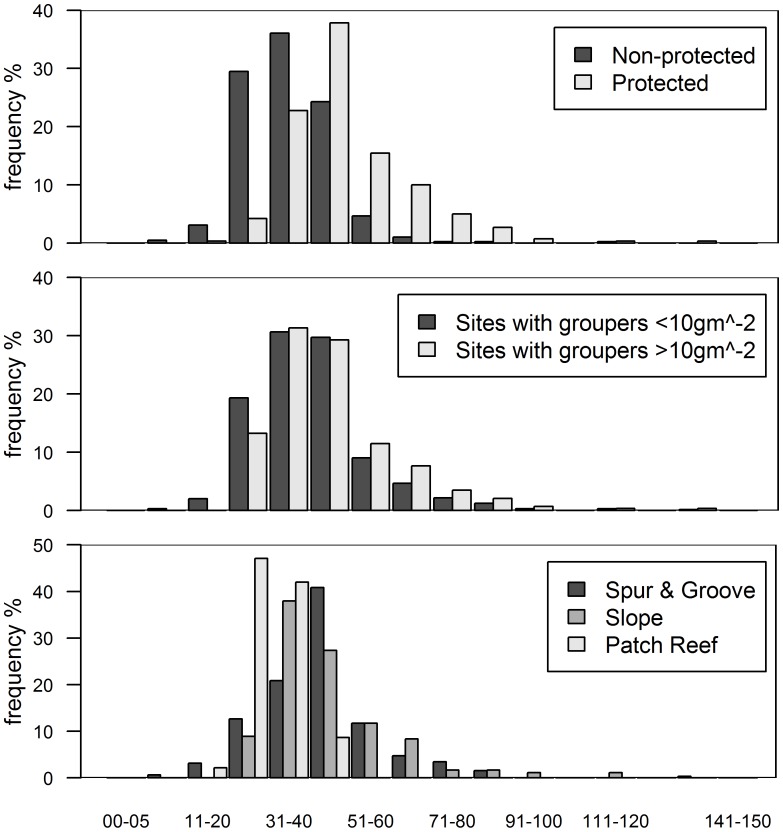
Histograms of grouper class size (total length in cm) by categories.(A) Class size distribution for protected and non-protected sites, (B) for sites with over and under 10 gm−2 of grouper biomass, and (C) for reef habitat types. Note that over 90% of protected sites and sites with >10 gm−2 of grouper biomass have individuals >30 cm in total length. Only every other class size has a label for clarity.